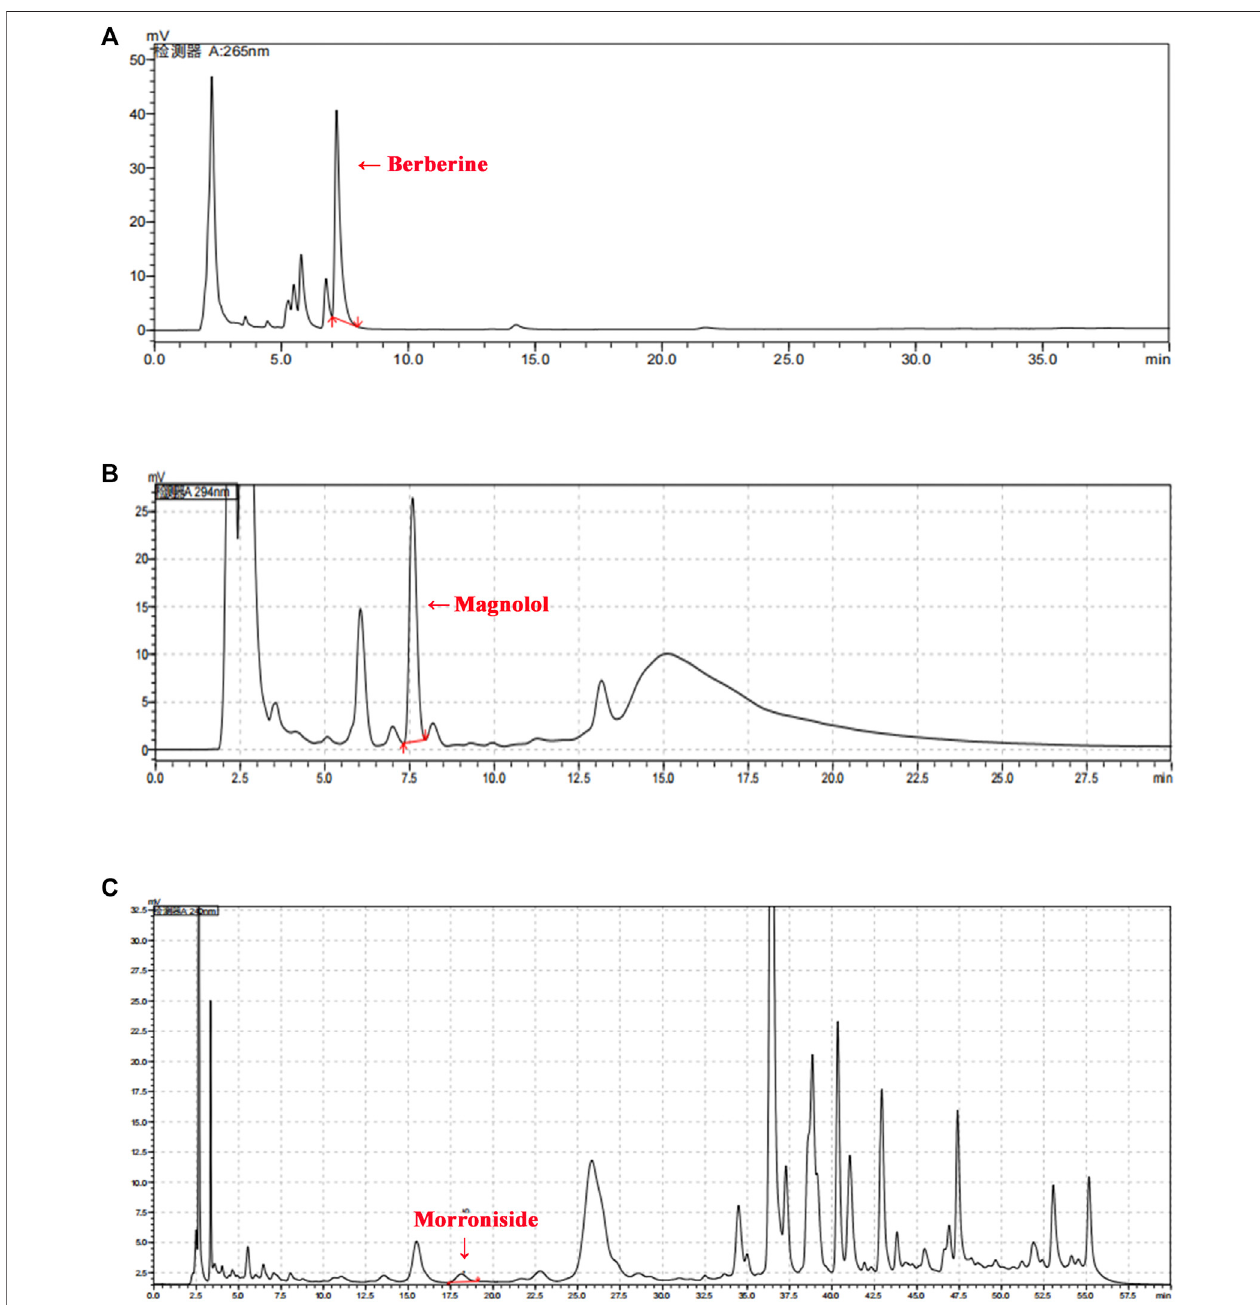
FIGURE 2 | HPLC chromatogram of SHTXF. Three major compounds (berberine, magnolol, and morroniside) of SHTXF were identi fi ed and compared with the standards using HPLC. The peaks of berberine [ (A) , 26 nm], magnolol [ (B) , 294 nm], and morroniside [ (C) , 240 nm] are indicated by red arrows.